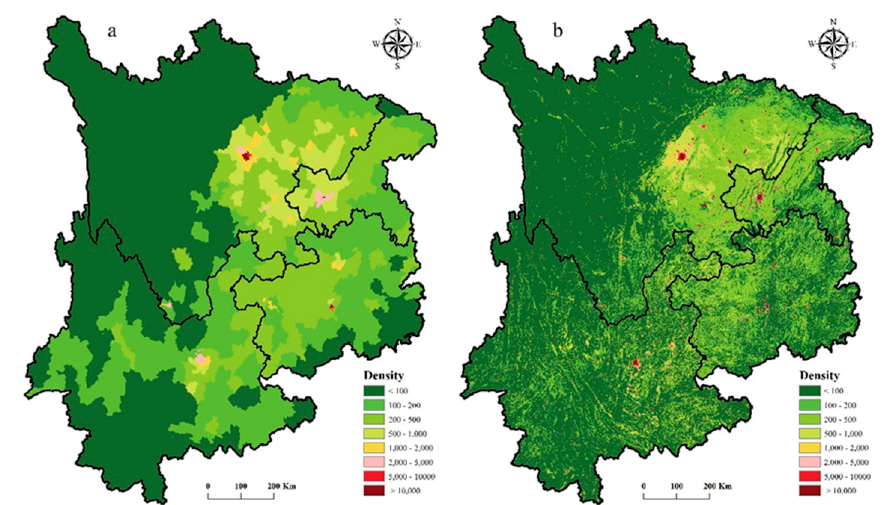
Figure 4. Comparison of the population distribution before and after spatializing in the study area: ( a ) county-level population density by census data; ( b ) the results of the spatial distribution of the population (SSDP).